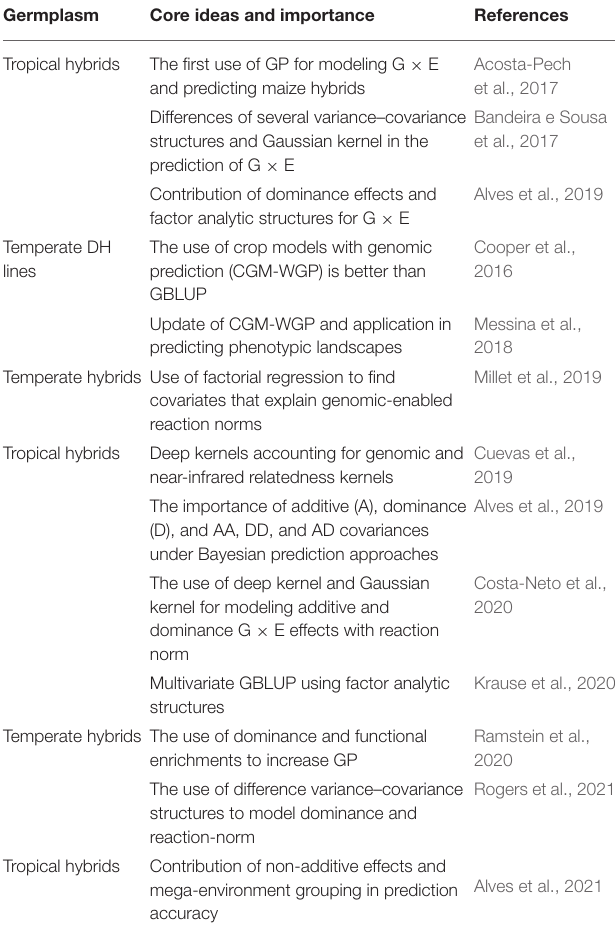
TABLE 2 | Strategies and main results for multi-environment genomic prediction of grain yield, the main agronomic trait in hybrid maize breeding since 2017.